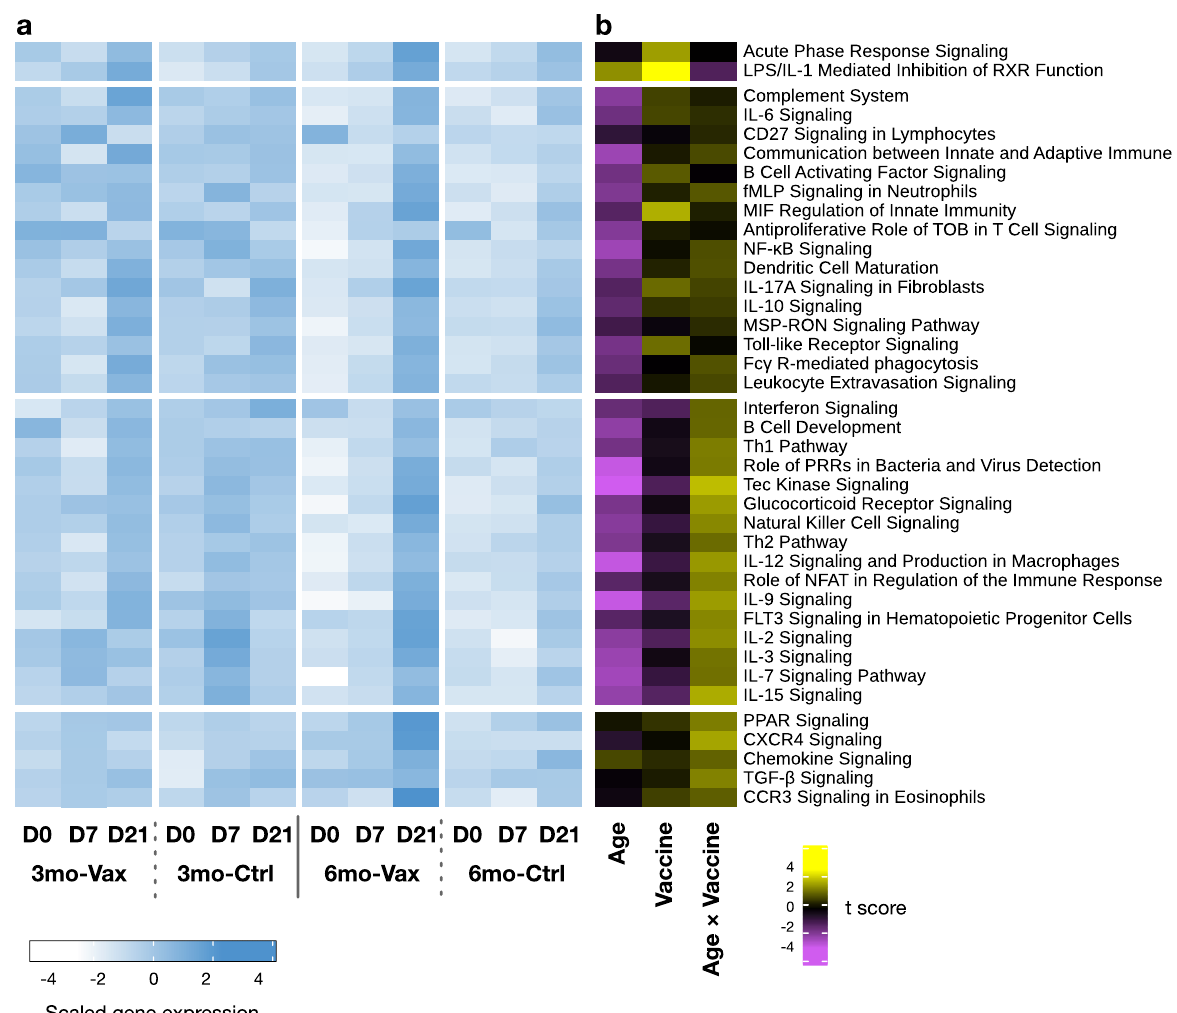
Fig. 4 Gene expression within immune pathways signi fi cantly affected by immunisation, age, or both. a Heat map of gene expression over time within the four treatments (3mo-Vax, 3mo-Ctrl, 6mo-Vax, and 6mo-Ctrl). High to low scaled expression is denoted with blue to white hues. b Heat map of a generalised mixed model t value statistic (number of standard deviations from the mean) 79 indicating the effect of age, vaccination, and the interaction between age and vaccination on the expression of each pathway. Purple indicates a dampening effect on the expression of the pathway while yellow indicates increased expression of that pathway relative to the global average. Pathways included are those presented in Fig. 2. The full list of gene expression is available in Supplementary Fig.